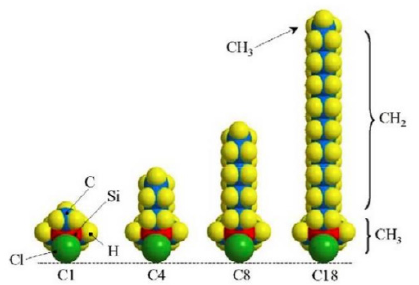
Figure 1. Alkyl chlorosilane molecule.